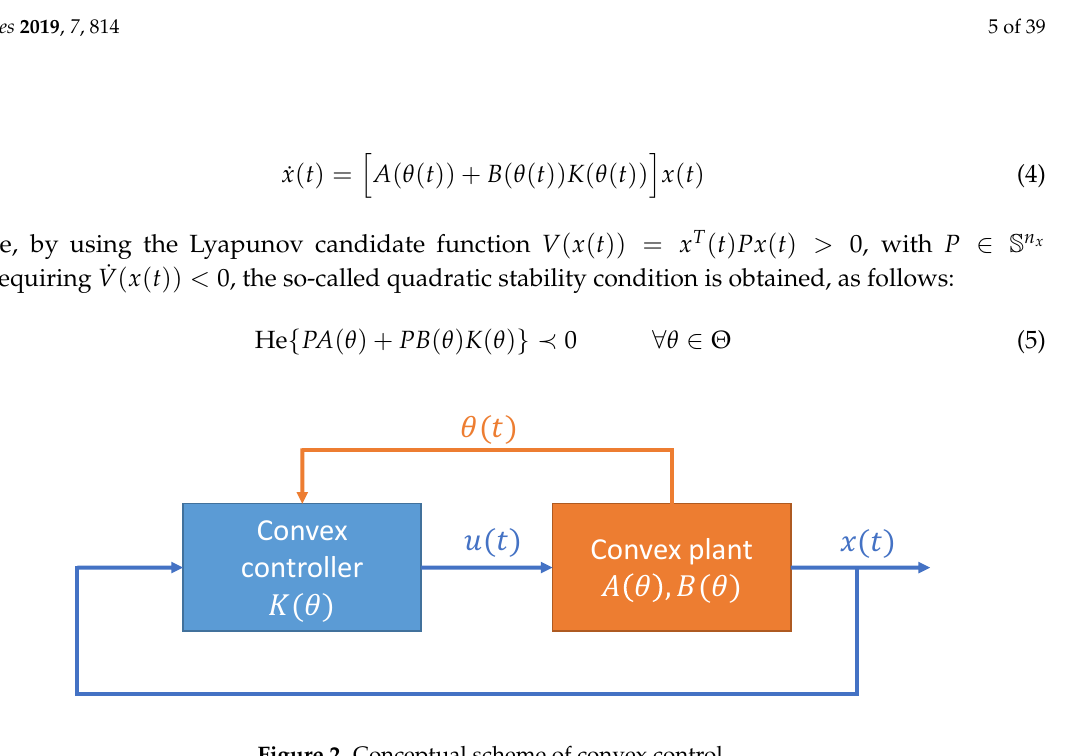
Figure 2. Conceptual scheme of convex